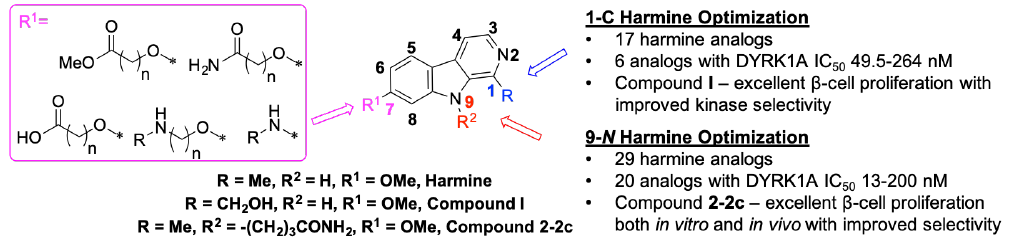
Figure 1. Optimization of the 7-position of harmine.